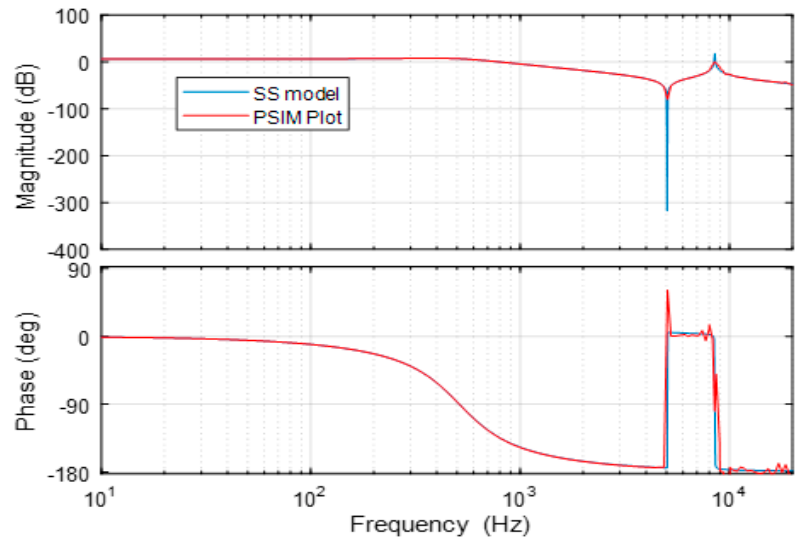
Figure 21. Audio-susceptibility transfer function.